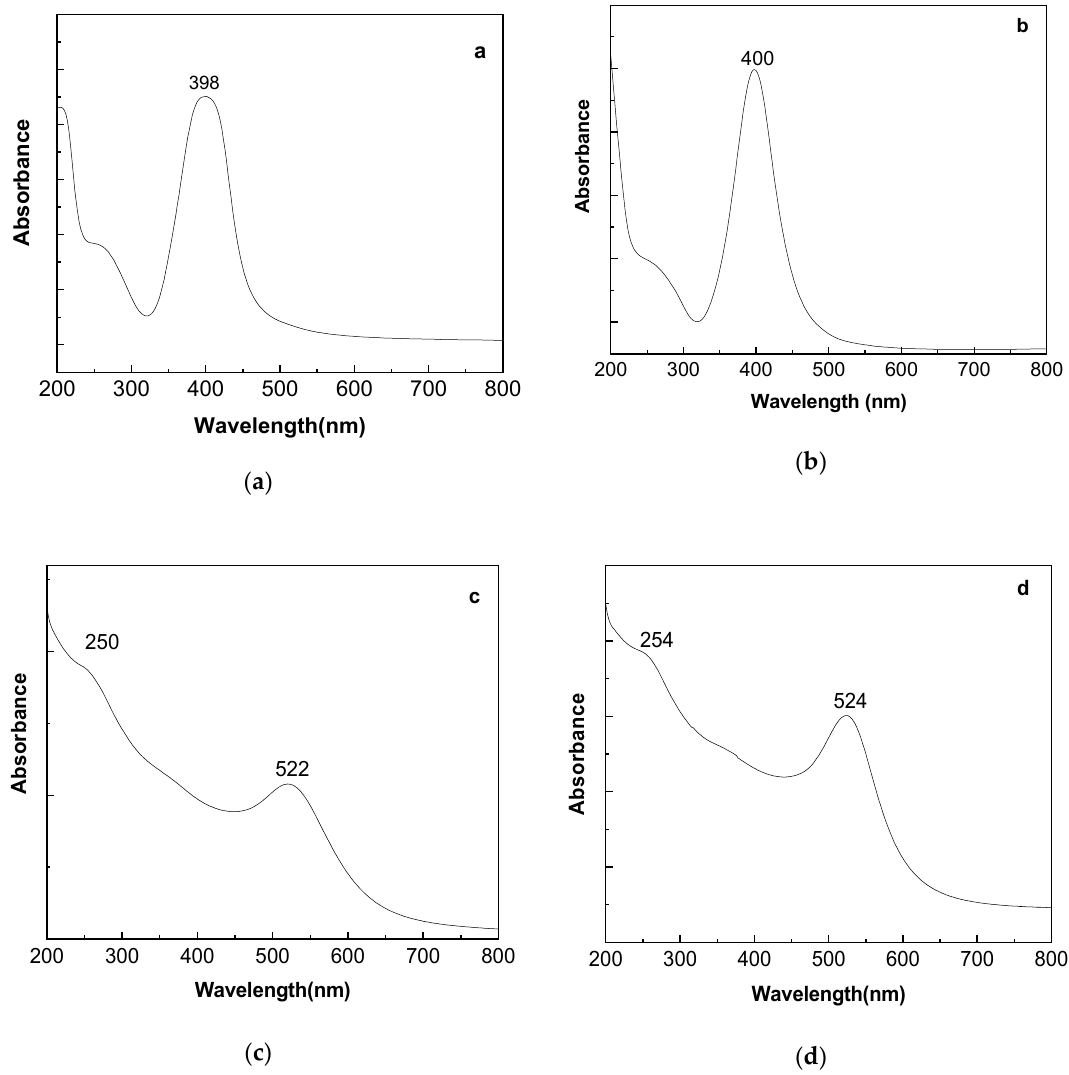
Figure 2. UV-VIS spectra of nanoparticles: ( a ) Ag with a particle size of 5 nm, ( b ) Ag with a particle size of 10 nm, ( c ) Au with a particle size of 5 nm, and ( d ) Au with a particle size of 10 nm.